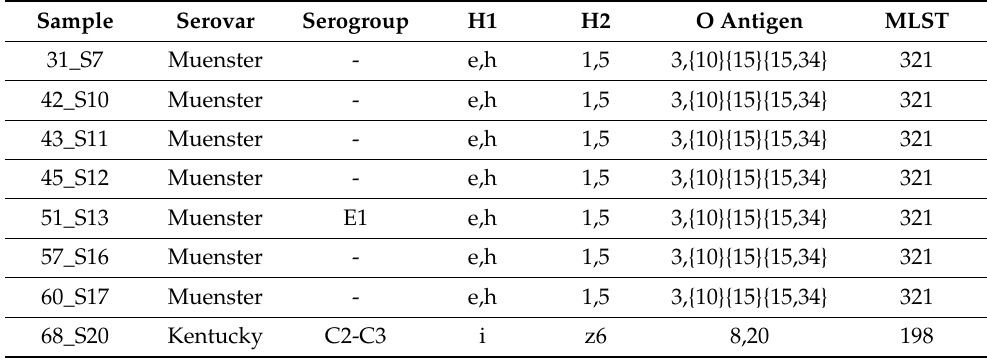
Table 1. Serotyping and cgMLST